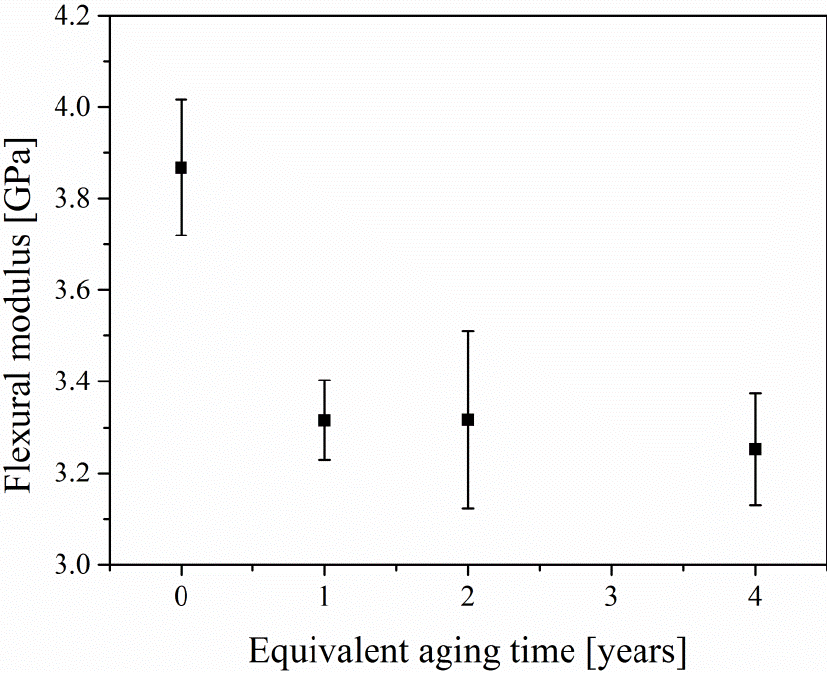
Figure 9. Flexural modulus of epoxy mortar at different aging times.